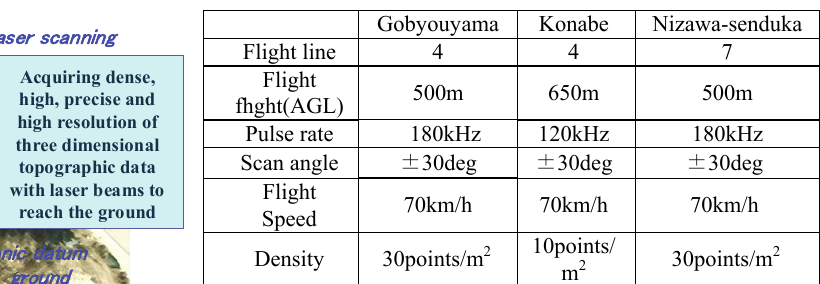
Table 1. Specification of Lidar survey